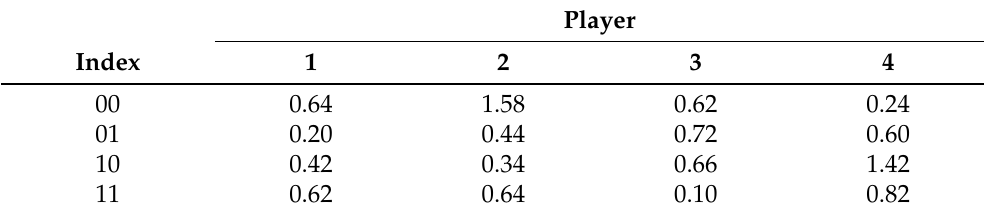
Table 1. Example